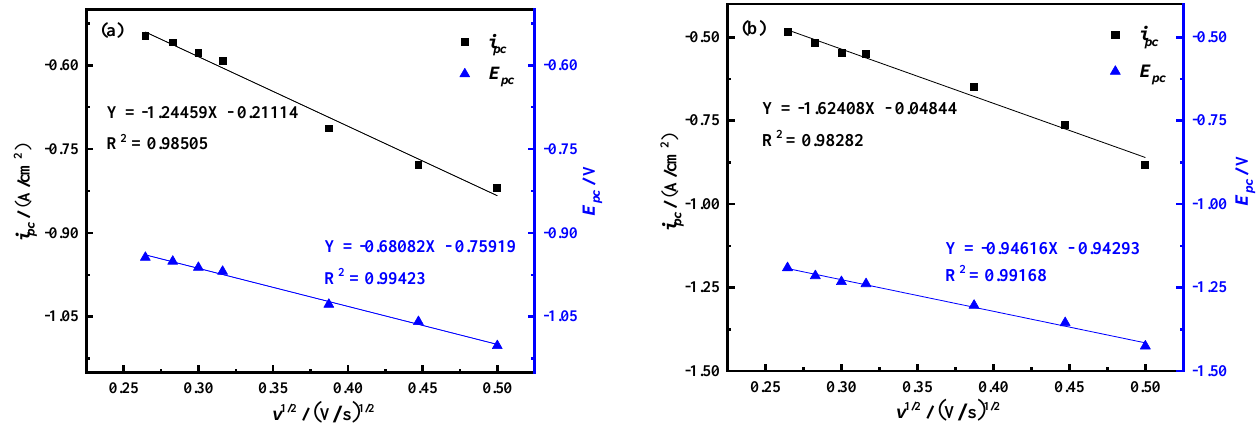
In the formula: R —molar gas constant (8.3145 J/mol/K), T —temperature (K), n —electron Figure 11. The log v - E pc and log v - E pa curves of peak B (A = 0.32 cm 2 ) ( a ) log v - E pc ( b ) log v - E pa . transfer number, F —Faraday’s constant (96,485 C/mol). The solution shows that n = 1.8, which is approximately equal to 2. Therefore, the number of electrons transferred in the electrochemical reduction reaction corresponding to peak B should be 2. In summary, Ni 3+ reduction is divided into two steps, namely Ni 3+ + e − = Ni 2+ , Ni 2+ + 2e − = Ni. The i pc - E pc - v 1/2 curves of peaks A and B were respectively drawn according to Figure 10, as shown in Figure 12. It can be seen from the figure that the i pc and v 1/2 of the two have a linear relationship. It can be judged that the reduction in Ni 3+ to Ni 2+ is controlled by the electron transfer step, and the reduction in Ni 2+ to Ni is controlled by the electron transfer step and the diffusion process.